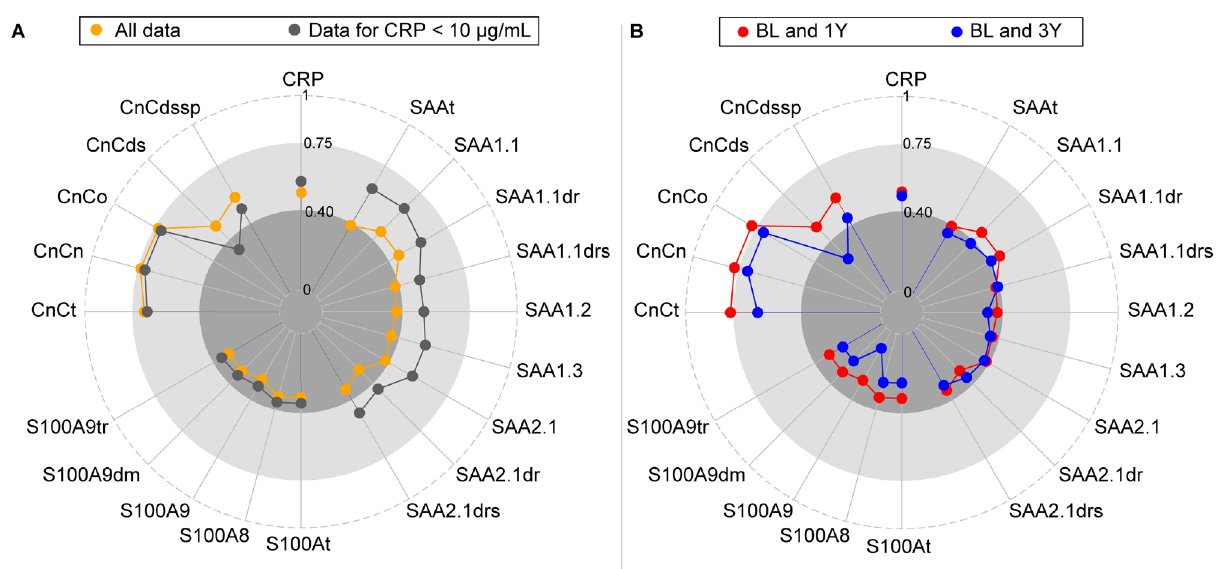
Figure 3. ICC changes after excluding outliers and according to the time interval from 1 to 3y. ( A ) After excluding 29 subjects with CRP > 10 µg/mL (outliers), ICCs of SAA increased from poor to fair-to-good while ICCs for the other biomarkers changed slightly. ( B ) ICCs of all the analytes increased across the time span. Thresholds of ICCs (< 0.4: poor; 0.4–0.75: fair to good; > 0.75: excellent) were marked by different tones of